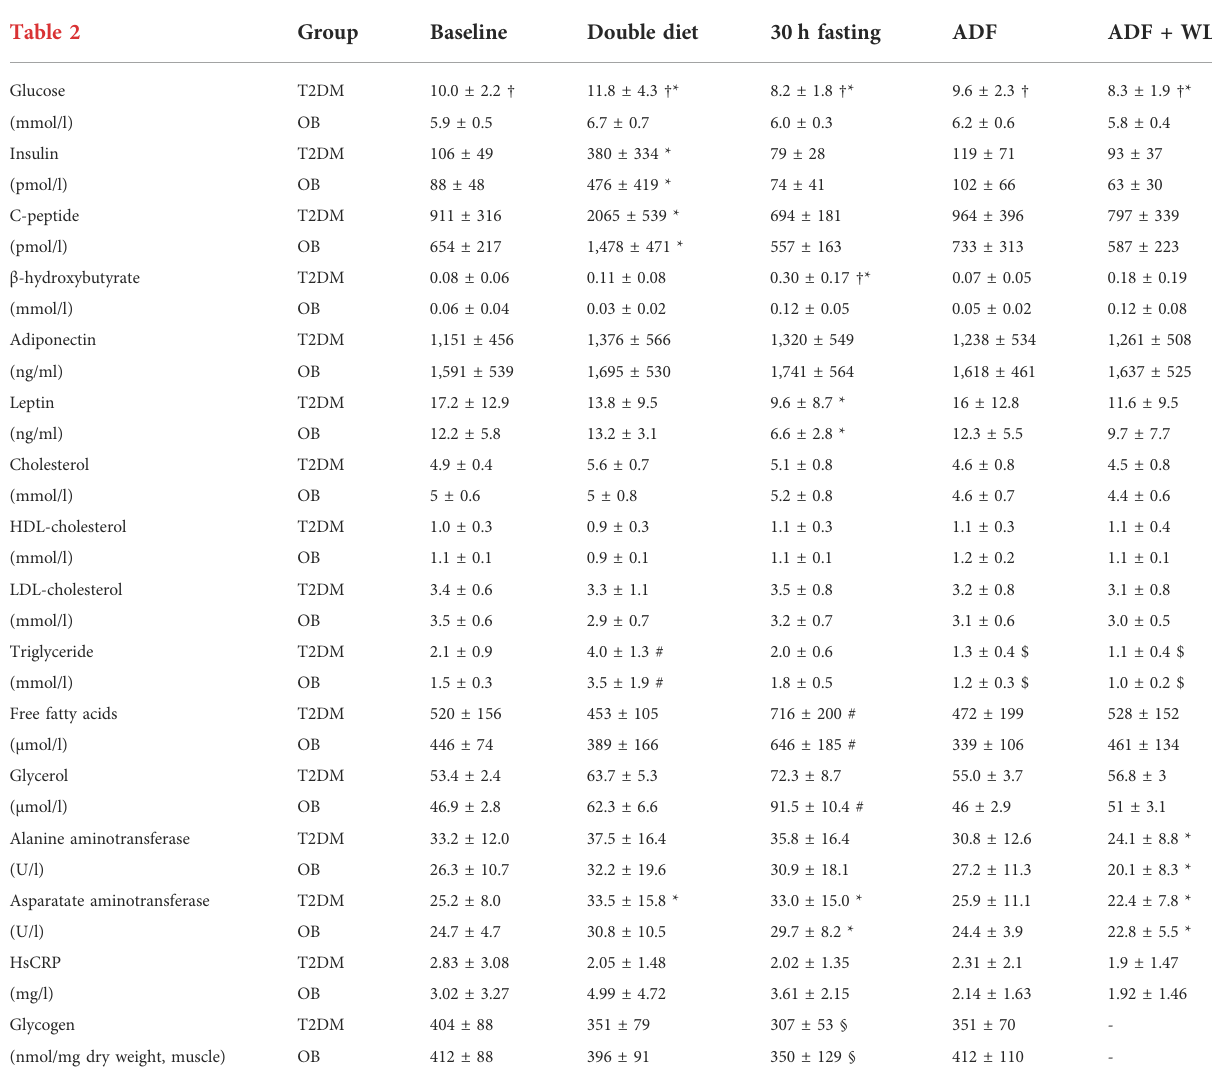
Table2:Plasmamarkersofenergyhomeostasisandintramuscularglycogencontentintwelvepatientswithobesityandtype2diabetes(T2DM)andelevenpatientswithobesity(OB)who participatedina6 weeksalternatedayfasting(ADF)protocol(seeFigure1).Venousbloodsampleswereobtainedinthefastingstateatstudystart(baseline),intheafternoon/eveningona double-diet day (i.e. non-fasting), after 30 h of fasting, in the morning in the fasting state after 3 weeks with alternate-day fasting without weight loss (ADF), and in the morning in the fasting stateafter 3 weekswith alternate-dayfastingwith allowed weightloss (ADF + WL). Glycogencontentin skeletalmuscle were obtained via microbiopsies(Tru-Cut)in theevening after a day with a double diet and after 30 h fasting. Dataaremean±SD.*denotesdifferentfrombaselinewithinthegroup,#denotesdifferentfromallothertimepointswithinthegroup,$denotesdifferentfrombaseline, †